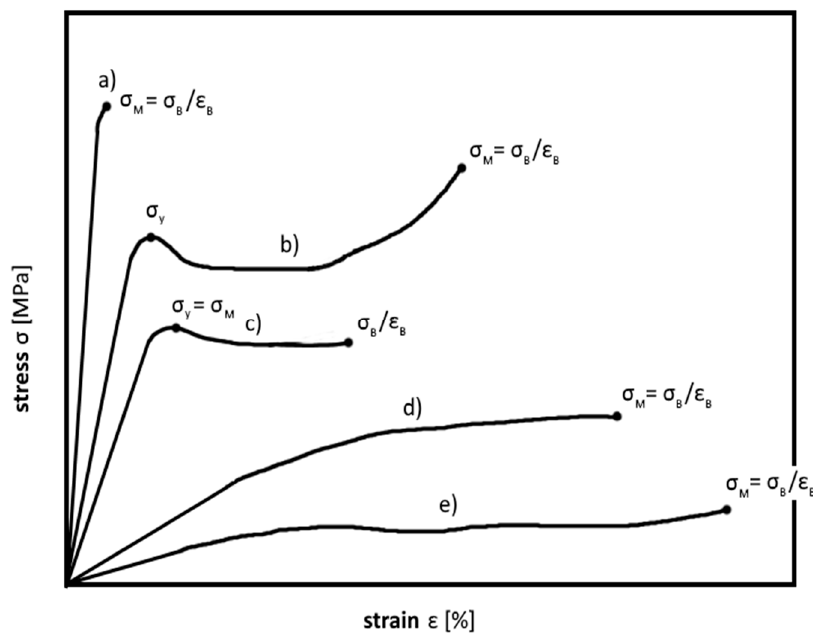
Figure 5. Stress–strain curves of various polymeric materials, ( a ) brittle materials; ( b , c ) tough materials with yield point; ( d ) tough material without yield point and ( e ) elastomeric materials.